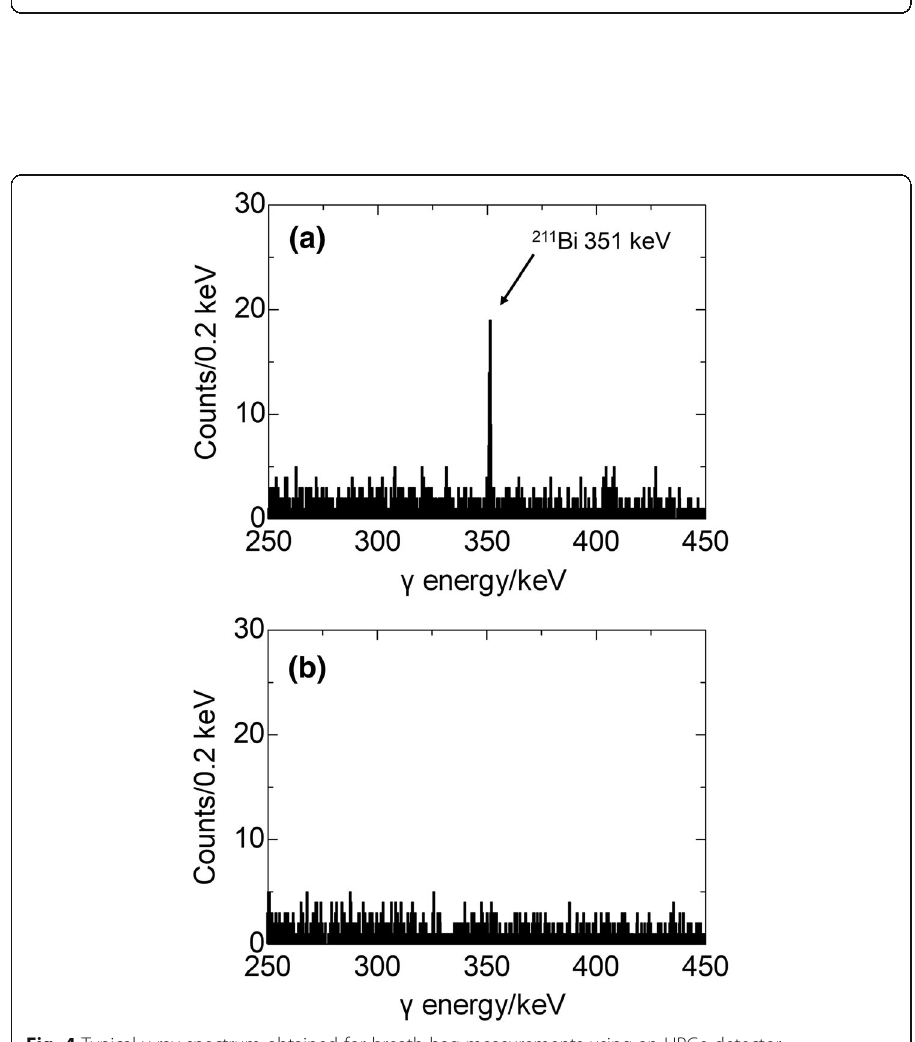
Fig. 4 Typical γ -ray spectrum obtained for breath bag measurements using an HPGe detector. Administration dose, 3.8 MBq; breath sampling time, 5 min after the start of administration; measurement start, a 17 min and b approximately 4 h after the end of breath